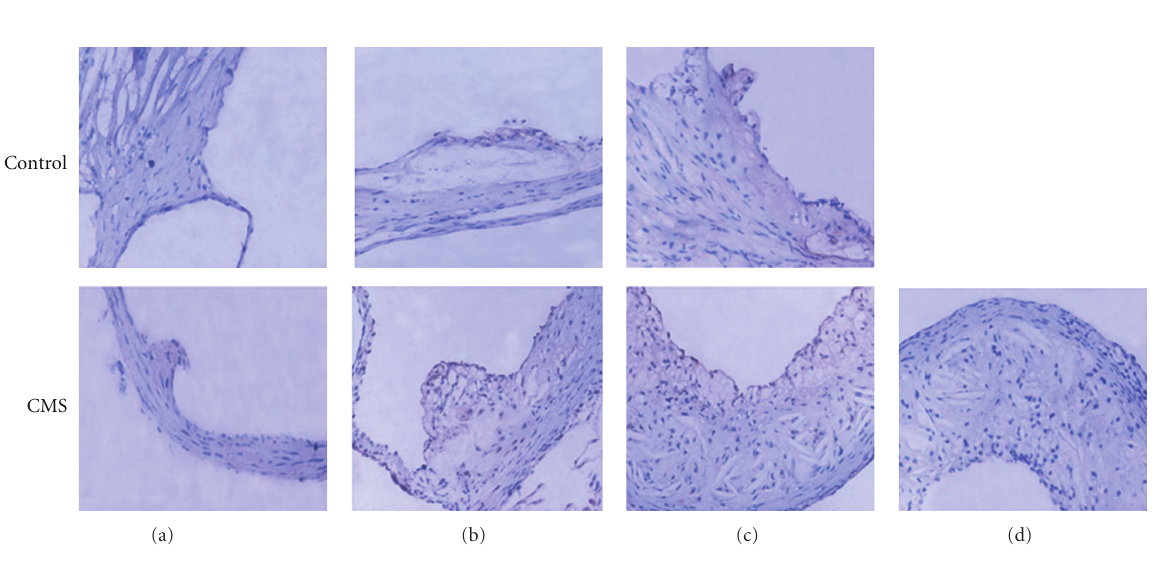
Figure 7: (a)–(c) Immunohistochemical evidence for TLR-4 expression within atherosclerotic plaque of aortic sinuses from control apoE-/- (top) and CMS (bottom) apoE-/- mice. 5 μ m frozen sections of the apoE-deficient mouse aortic root were fixed with acetone for 5 minutes at room temperature and then immunostained with Rabbit antimouseTLR4 antibody (1 : 100). Rabbit IgG was used as a negative control. (a)–(c) represent TLR-4 expression within aortic sinus of apoE-/- mice exposed to normal condition (control) or CMS for 0 week, 4, and 12 weeks, respectively (brown staining); (d) represents rabbit IgG staining for negative control. In (a) there is minimal immunoreactivity to TLR-4 in nonatherosclerotic aortic sinus of apoE-/- mouse (magnification ×